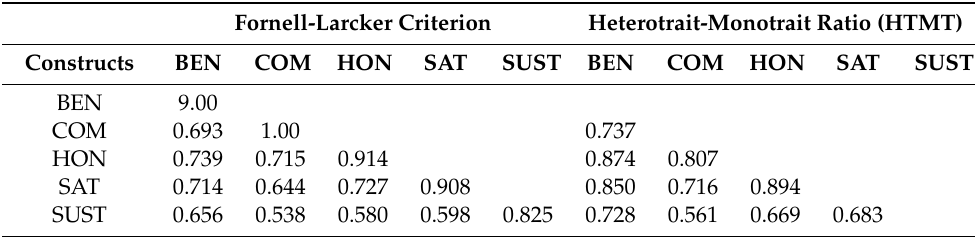
Table 3. Measurement of the first-order model (discriminant validity).